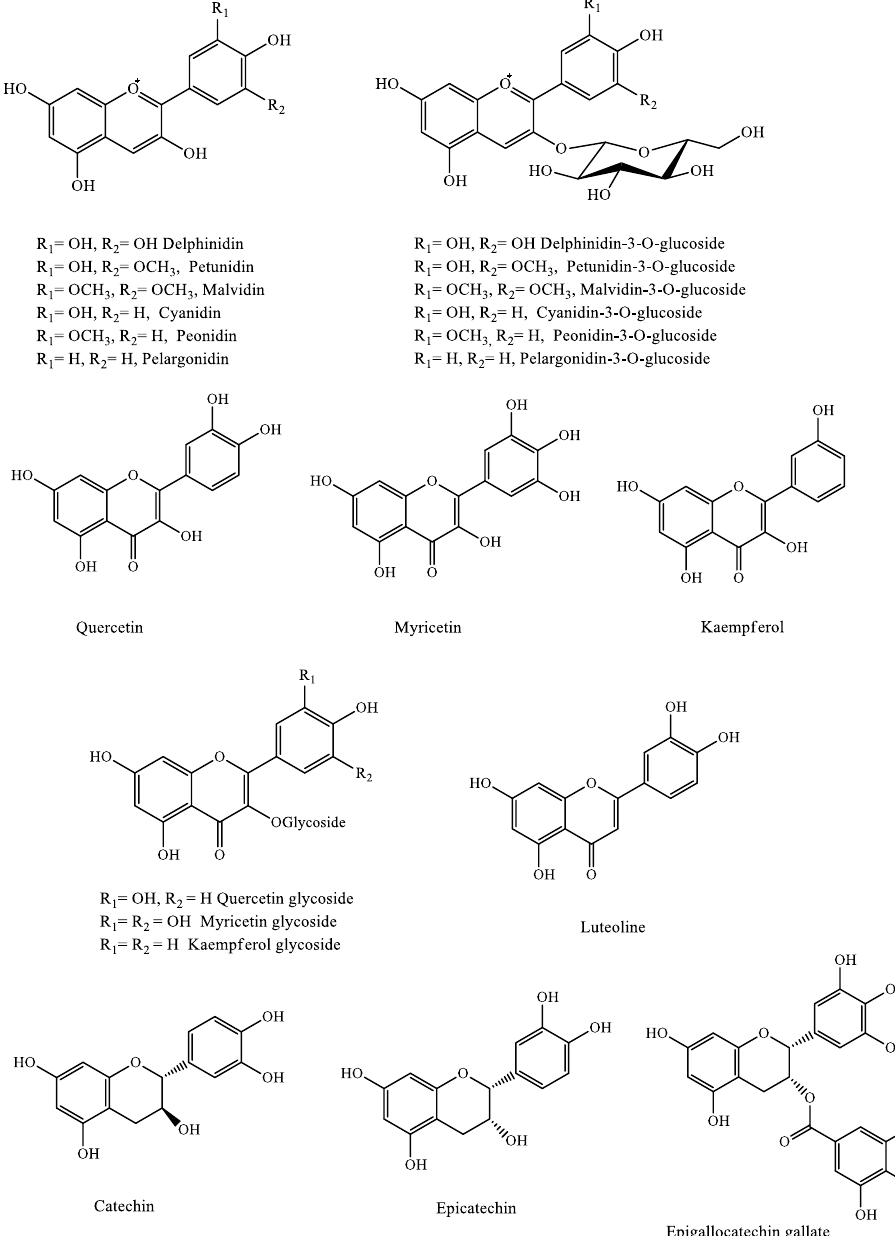
Figure 1. Chemical structures of major flavonoids contained in